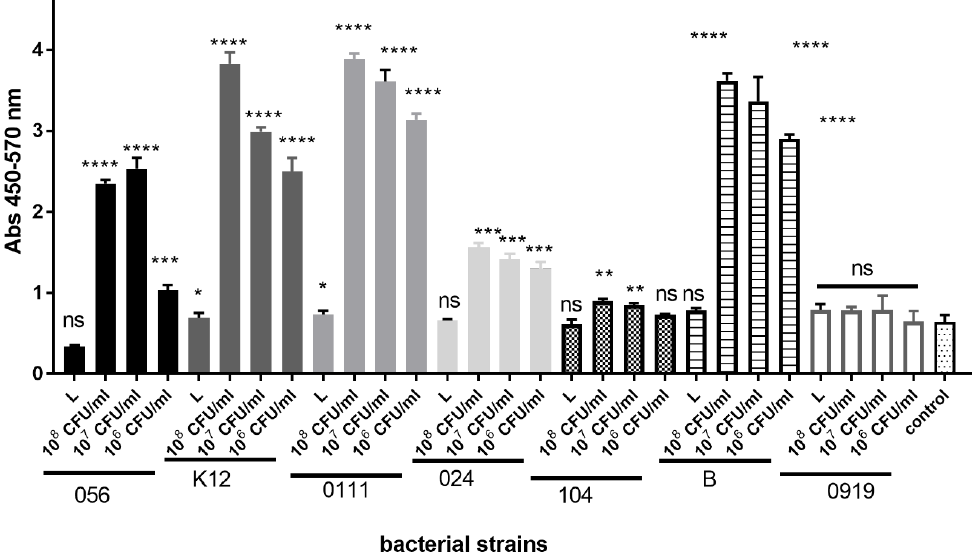
Figure 4. The reactivity in the ELISA test of polyclonal anti- Escherichia coli antibody conjugated with HRP (1:2000) with Escherichia coli strains: 056, K12, 0111, 024, 104, B, and Lactobacillus rhamnosus LOCK